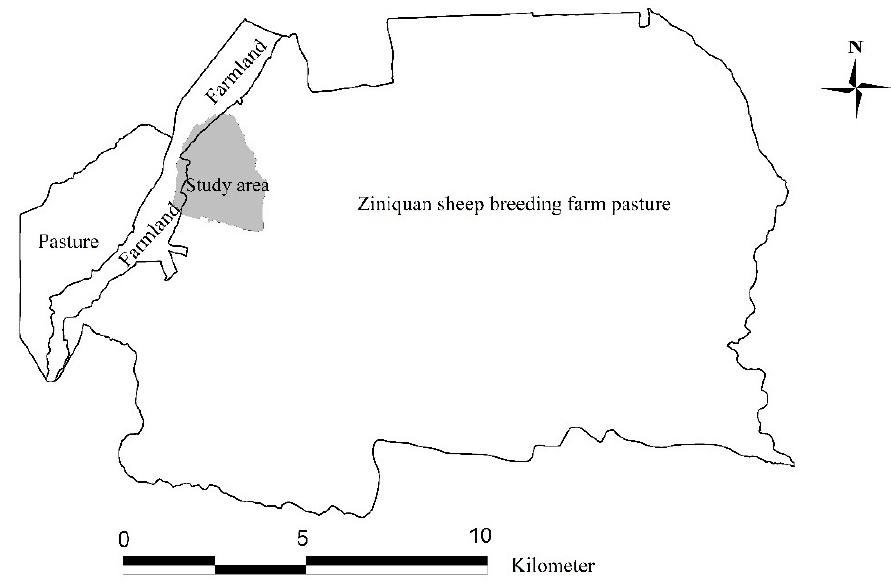
Figure 1. Location of research area (44°00′13.23″ N, 85°46′15.06″ E).